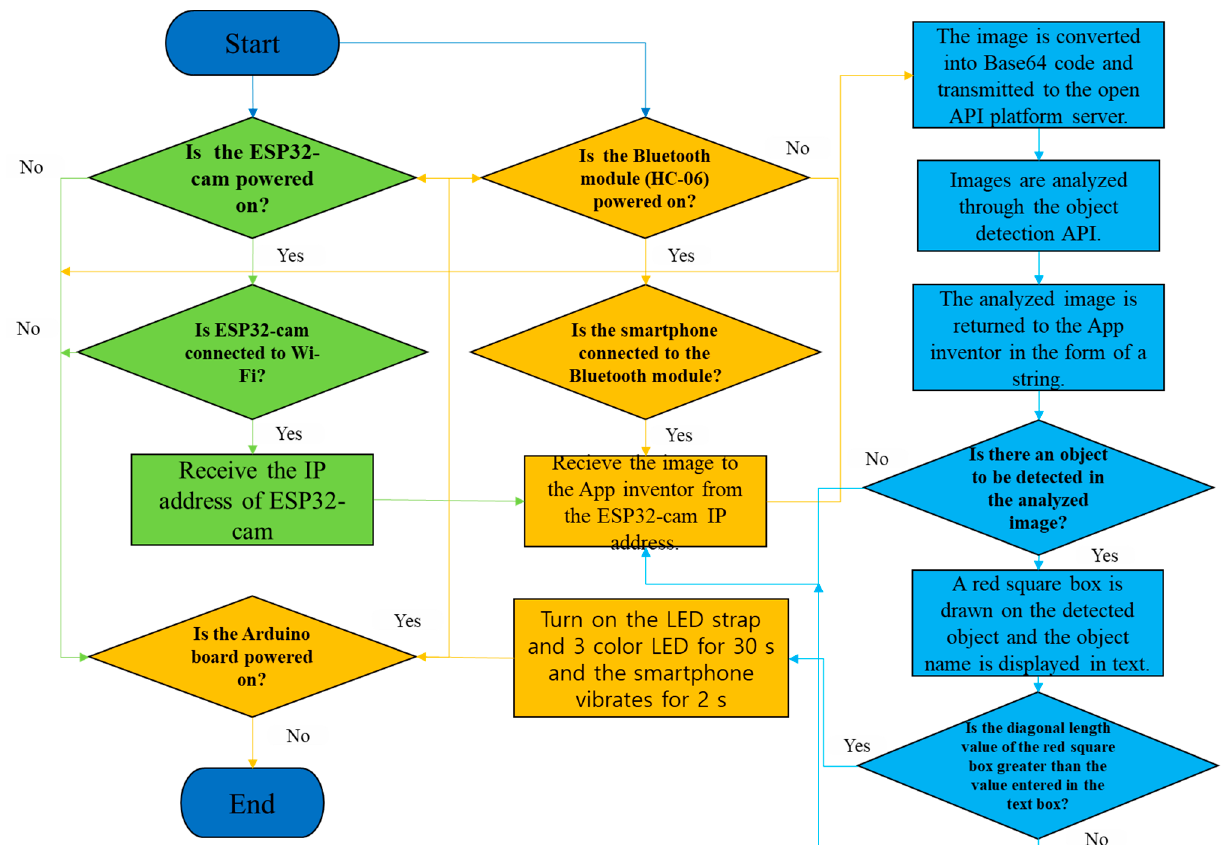
Figure 5. Operation algorithm of the AI smart helmet-based collision prevention system.